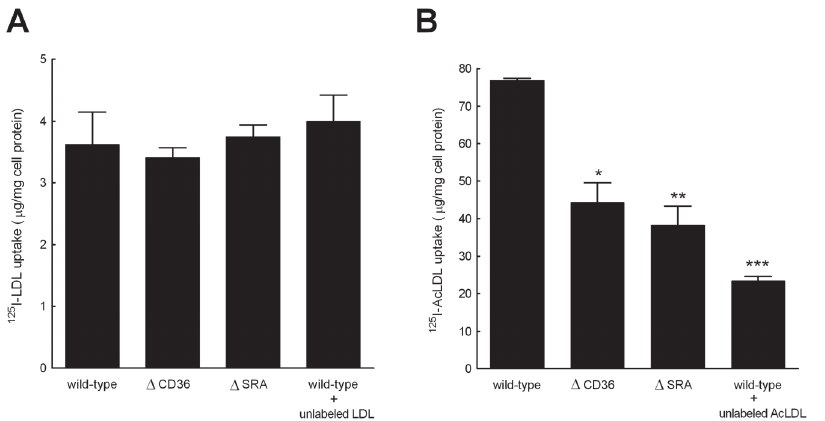
Figure 3. Fluid-phase pinocytosis mediates LDL uptake. (A) Wild-type macrophages were incubated 6 h with either 25 m g/ml 125 I-LDL alone, or 25 m g/ml 125 I-LDL and 500 m g/ml unlabeled LDL. CD36 KO macrophages ( D CD36) and SRA KO macrophages ( D SRA) macrophages were incubated 6 h with 25 m g/ml 125 I-LDL alone. (B) Wild-type macrophages were incubated 6 h with either 25 m g/ml 125 I-AcLDL alone, or 25 m g/ml 125 I-AcLDL and 500 m g/ml unlabeled AcLDL. CD36 KO macrophages ( D CD36) and SRA KO macrophages ( D SRA) macrophages were incubated 6 h with 25 m g/ml 125 I- AcLDL alone. Incubations were performed in serum-free medium containing 50 ng/ml M-CSF. Uptake values represent the sum of cell-associated and degraded 125 I-labeled lipoprotein. The range of cell-associated and degraded 125 I-LDL was 17–21% and 79–83%, respectively. The range of cell- associated and degraded 125 I-AcLDL was 16–18% and 82–84%, respectively. 125 I-LDL uptake was not competed with excess unlabeled LDL consistent with fluid-phase pinocytosis mediating uptake. Statistical tests compare each treatment group with wild-type macrophages incubated with 25 m g/ml